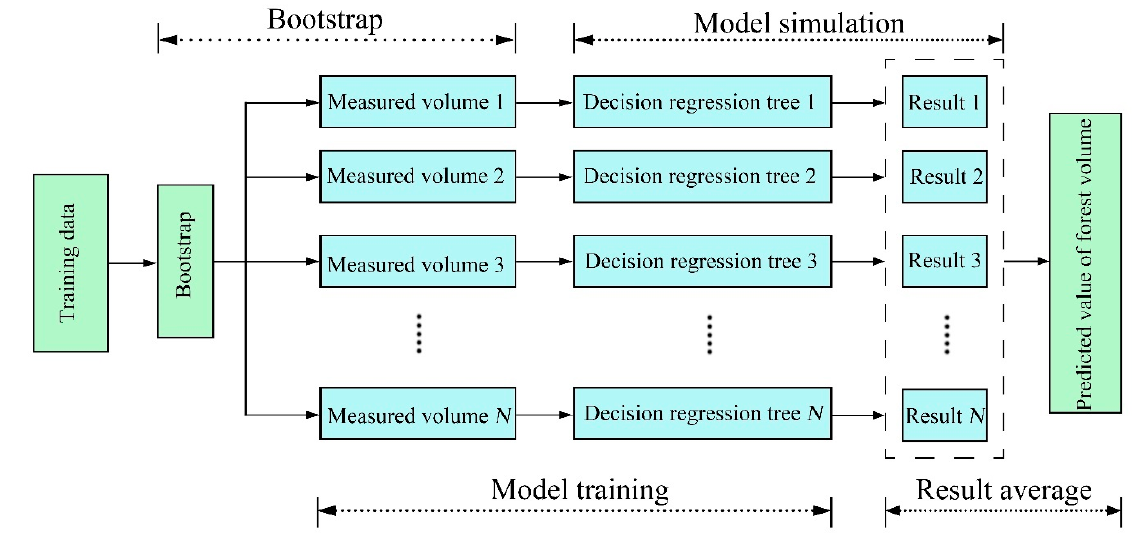
Figure 5. Schematic diagram of random forest regression. Through bootstrapping, a number of weak learners are trained by different decision regression trees, parameters, and features, and the final results are output by the weighted average method.